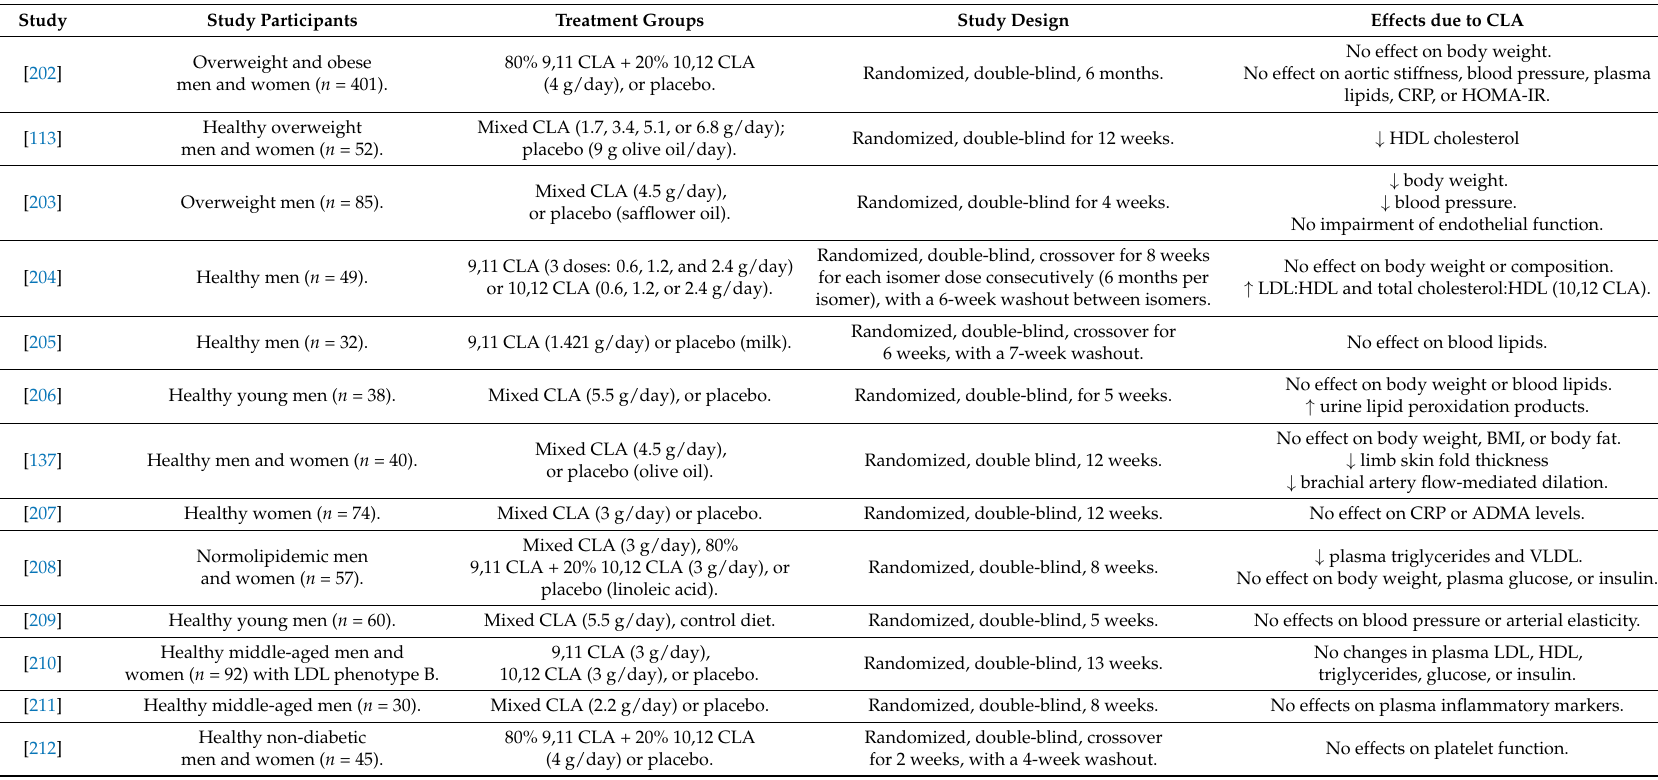
Table 2. Human studies with endpoints related to atherosclerosis or cardiovascular